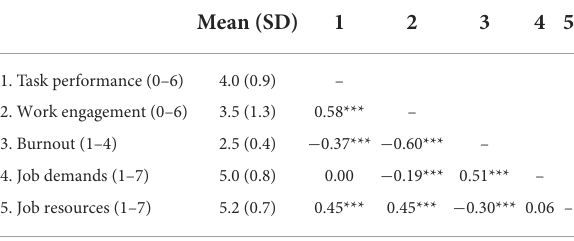
TABLE 1 Descriptive statistics and correlations of key